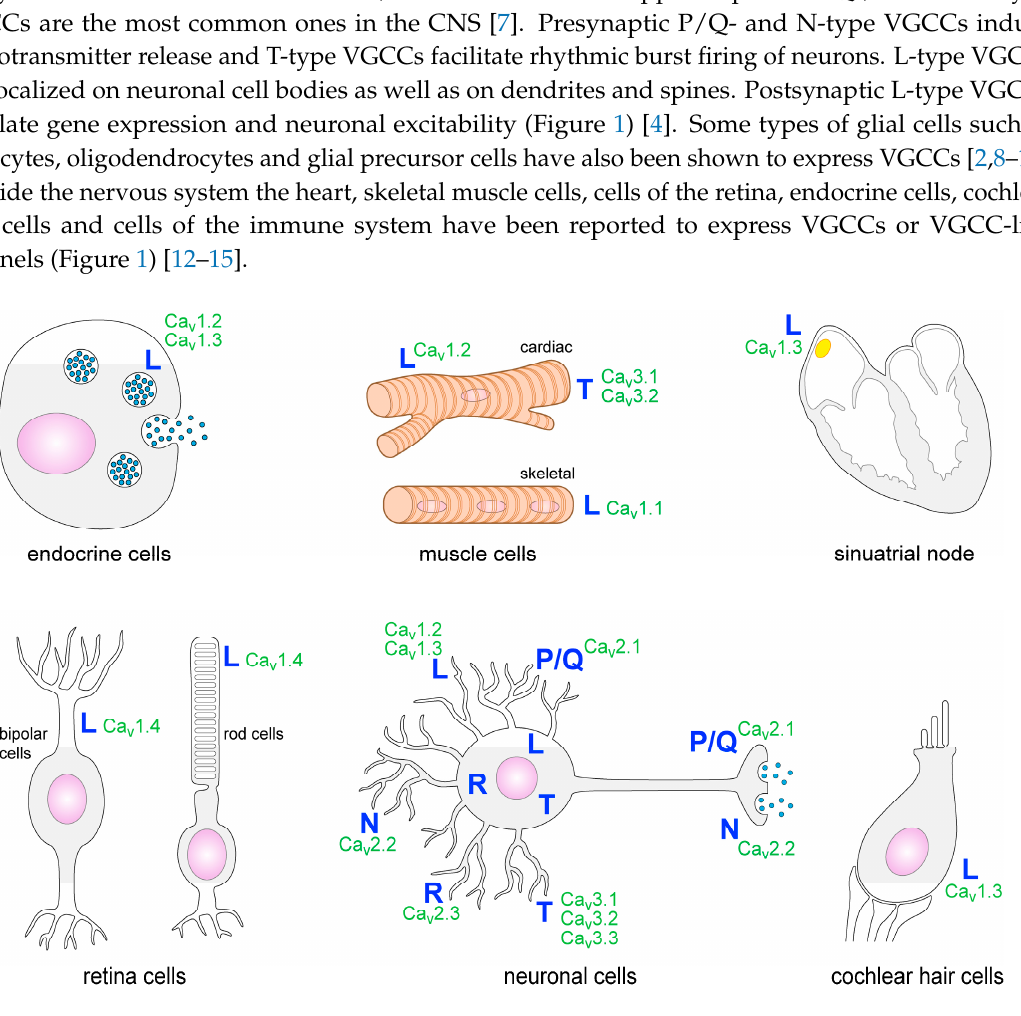
Figure 1. Distribution of VGCC subtypes on different cell types.